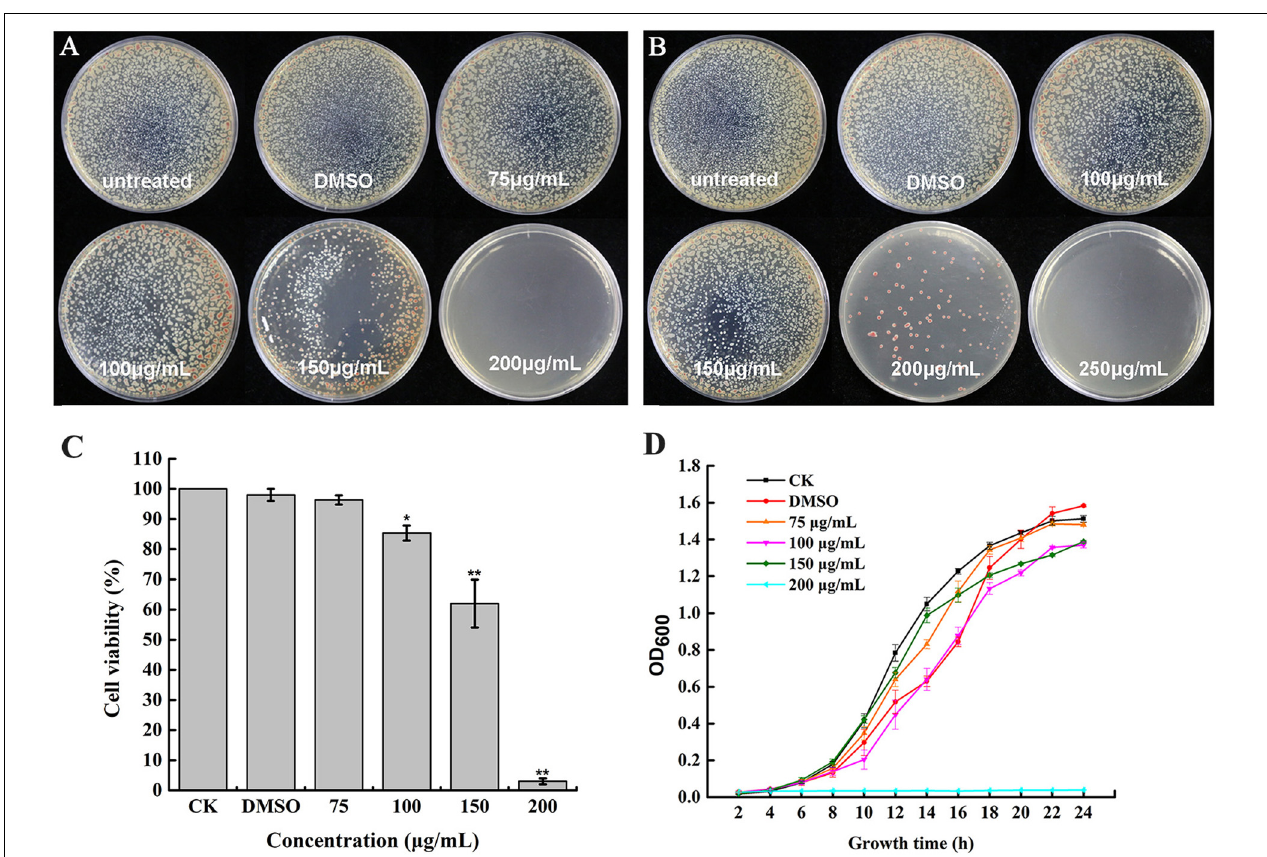
FIGURE 2 | Antibacterial activity of caffeic acid against R. solanacearum . The growth of R. solanacearum on plates was determined at 48 (A) and 96 h (B) . The R. solanacearum cell viability rate (C) and growth curve after exposure to different concentrations of caffeic acid (D) . The assay was independently replicated four times. The error bars indicate the standard errors from four independent replicates, and * and ** indicate significant differences identified according to independent-sample t -tests with a p -value of 0.05 and 0.01, respectively.